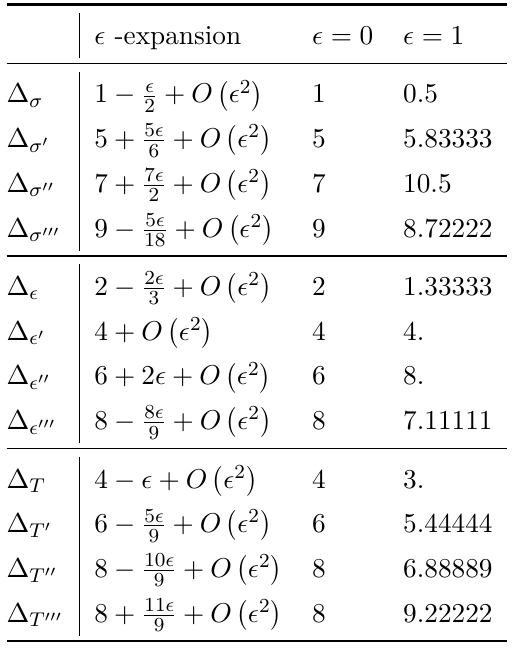
Table 2 . The dimensions of the lowest dimensional Z 2 -odd and Z 2 -even scalars and Z 2 -even spin-2 operators in the 3d Ising model according to the (cid:15) -expansion (up to order O ( (cid:15) ) ) [15, 16]. The free theory (i.e. (cid:15) = 0 ) values are shown in the second column while the evaluation of the first order (cid:15) -expansion at (cid:15) = 1 is shown in the last column. While the latter estimates are of course not very accurate at (cid:15) = 1 , they offer (weak) support that each of these sectors contains two operators with a dimension below